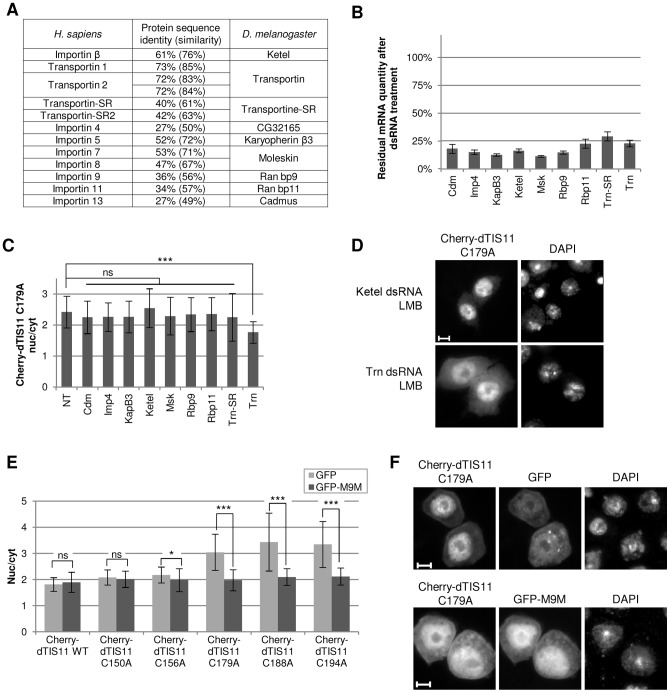
Screening of Drosophila importins to identify dTIS11 nuclear import machinery.(A) Human karyopherins and their Drosophila homologs. The identity/similarity of sequence is indicated. (B) Inhibition of Drosophila karyopherin expression by RNA interference. S2 cells were incubated for 4 days in the absence or in the presence of dsRNA targeting the indicated karyopherins. Cells were harvested and karyopherin mRNAs were quantified by qRT-PCR. The values are expressed relatively to untreated samples. The error bars represents the standard deviation over a triplicate measure. (C) Subcellular distribution of Cherry-dTIS11 C179A protein upon inhibition of karyopherin expression. S2 cells were treated with dsRNA targeting the indicated karyopherins as described in (B), transfected with Cherry-dTIS11 C179A construct and treated with LMB (10 ng/ml, 1h). Data acquisition and quantification were performed as in Fig. 2. Bars show the average of the nuc/cyt ratio ± s.d. ns: non-significant (p>0.05); ***: p<0.0001 (U-tests). (D) Representative images of the nucleo-cytoplasmic distribution of Cherry-dTIS11 C179A mutant in Ketel dsRNA- and Trn dsRNA-treated S2 cells in the presence of LMB. Bar  =  5 µm. Results shown in (B), (C) and (D) are representative of three independent experiments. (E) S2 cells were transfected to express wild-type or mutant versions of dTIS11 fused to Cherry, in combination with GFP alone or in fusion with the M9M peptide. Twenty hours post-transfection, cells were treated with LMB (10 ng/ml, 1h), fixed and observed by direct fluorescence microscopy. The subcellular distribution of the Cherry fusions was quantified as described in Fig. 2 for cells exhibiting GFP fluorescence. Bars show the average of the nuc/cyt ratio ± s.d. *: p<0.05; ***: p<0.0001; ns: non-significant (p>0.05) (t-tests). The absence of significant difference between Cherry-dTIS11 WT nuc/cyt ratios in GFP versus GFP-M9M-expressing cells and the significant difference between Cherry-dTIS11 C179A nuc/cyt ratios in these two conditions were observed in five independent experiments. (F) Representative images of the nucleo-cytoplasmic distribution of Cherry-dTIS11 C179A in S2 cells expressing GFP or GFP-M9M and treated with LMB as in (E). Bar  =  5 µm.